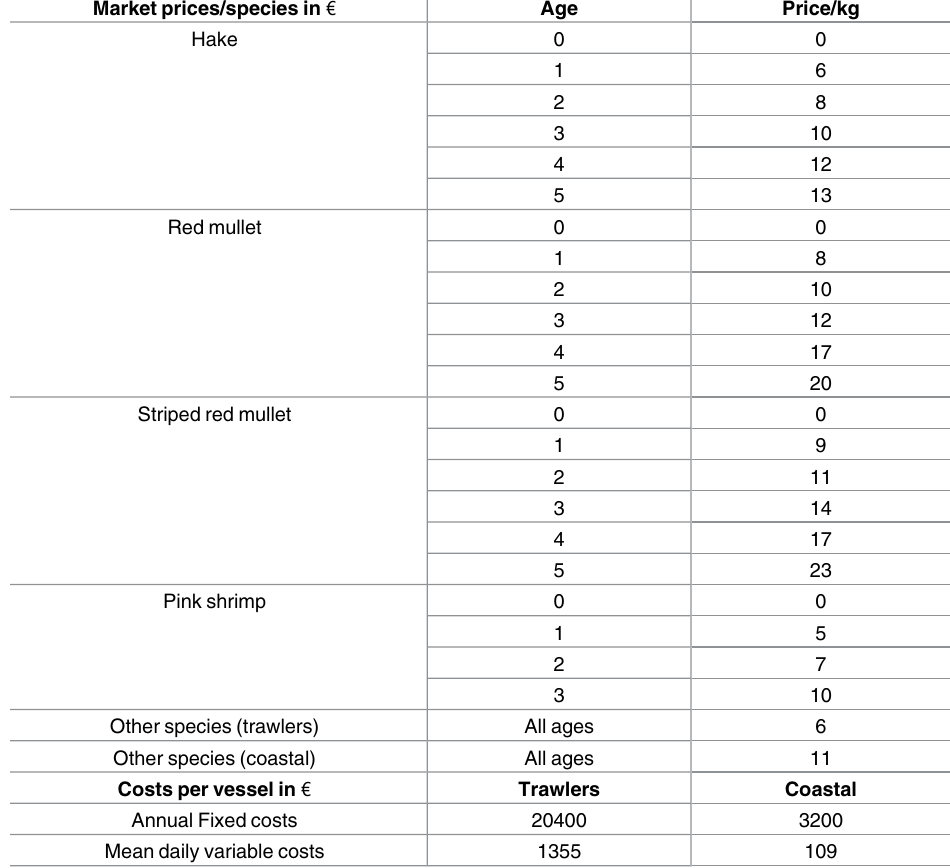
Table 2. Initial conditions in economic parameters. Market prices/species in